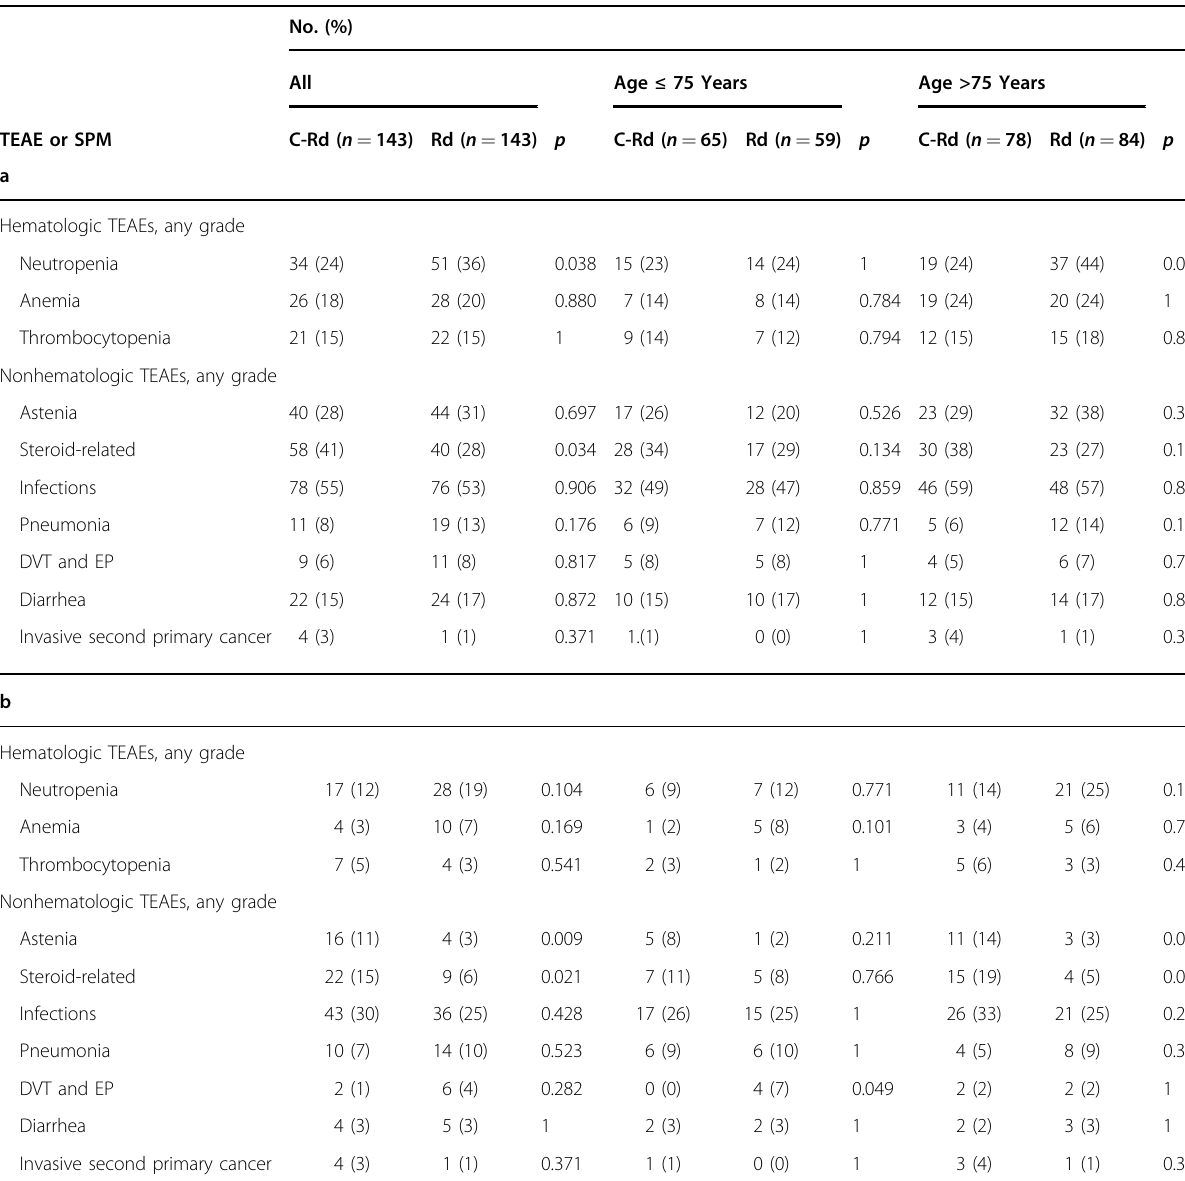
Table 4 a Most common adverse events and second primary malignancies reported during treatment in the safety population. b Most common adverse events of grade 3 – 4 reported during treatment in the safety